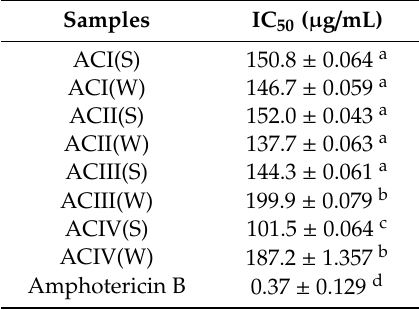
Figure 5. Principal component analysis of variation of chemical composition in anthocyanidins among eight extracts of Arrabidaea chica Verlot: scores plot. 3 (cid:48) -OH-carajurone = 3 (cid:48) -hydroxy-carajurone.